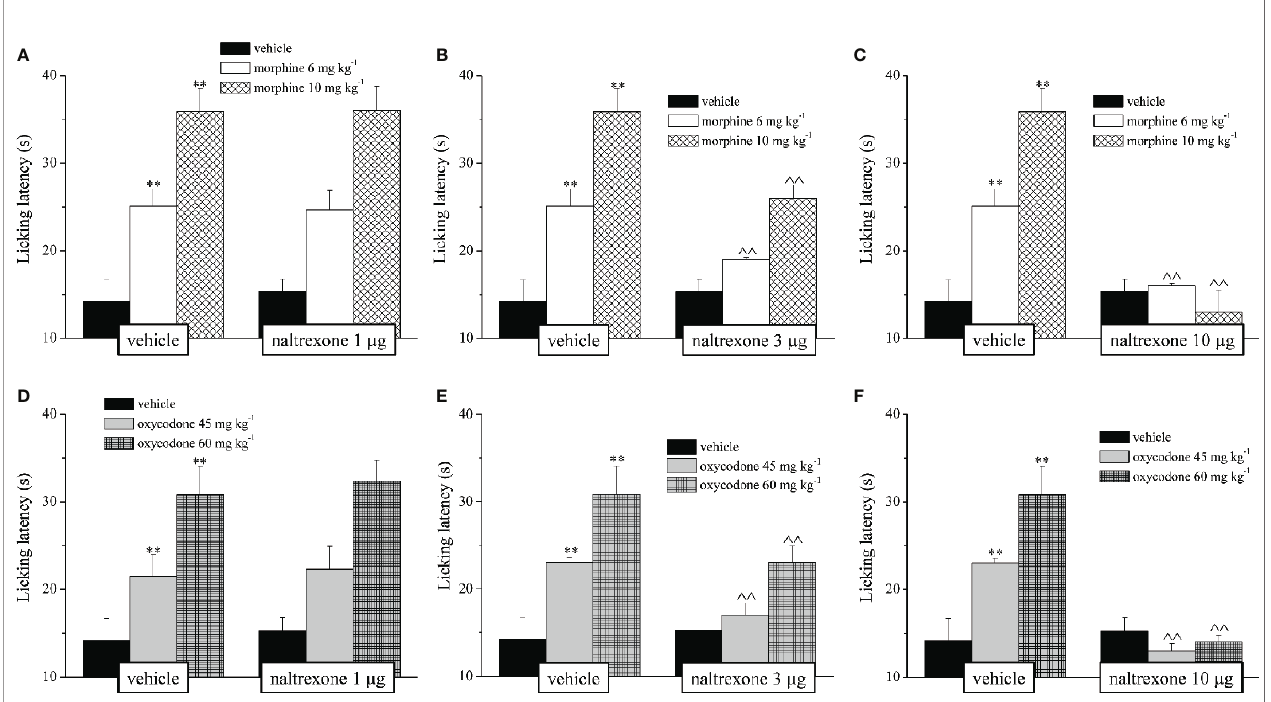
FIGURE 1 | Effect of intranasal administration of naltrexone on morphine and oxycodone analgesia. The response to a thermal non noxious stimulus was evaluating by measuring the licking latency (s) as a pain related behaviour by the Hot plate test. Naltrexone (1, 3 and 10 mg) was intranasally administered 30 min before the intraperitoneal injection of (A – C) morphine (6 and 10 mg kg -1 ) or (D – F) oxycodone (45 and 60 mg kg -1 ). Behavioural measurements were performed 30 min after opioids treatment. Control animals were treated with vehicles. Each value represents the mean of 10 mice per group, performed in two different experimental set. **P < 0.01 vs vehicle-treated animals; ^^P < 0.01 vs morphine or oxycodone- treated